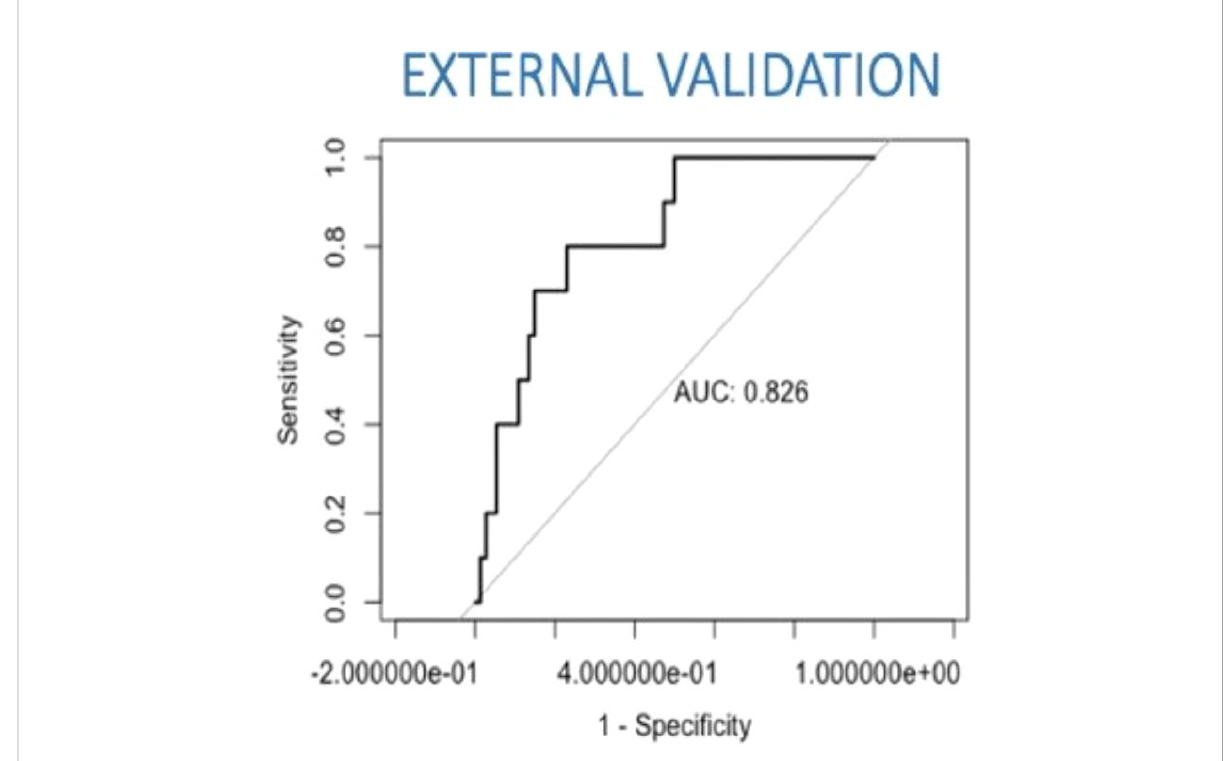
FIGURE 4 External validation with a Canadian population. AUC, area under the